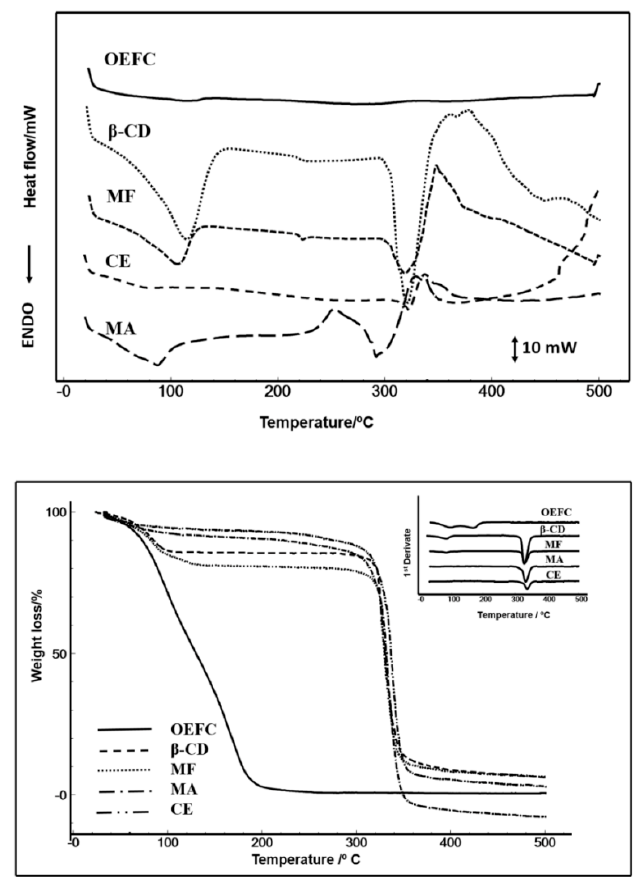
Figure 1. Differential scanning calorimetry (DSC) ( A ) and thermogravimetry (TG) ( B ) of β cyclodextrin ( β -CD) obtained by physical mixture (MF), malaxation (MA), and co-evaporation (CE), in a nitrogen inert atmosphere. Curves from the complex Croton rhamnifolioides essential oil (OEFC).